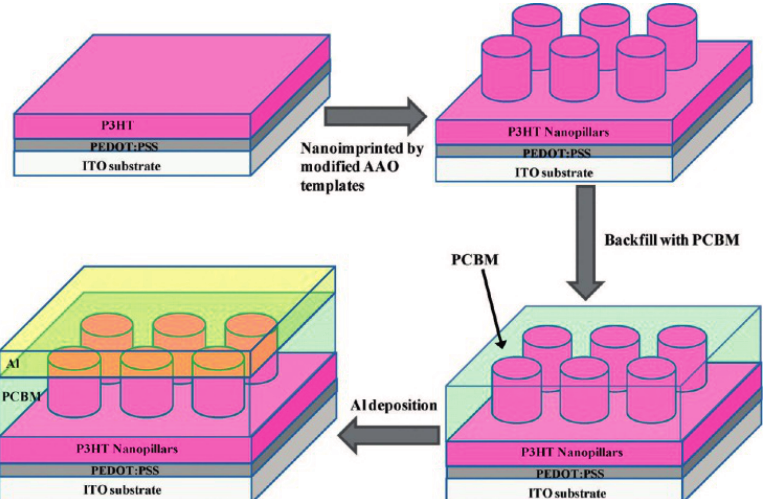
Figure 7. Procedure for the nanostructured organic photovoltaic device. Cited from [93]. Copyright 2012, America Chemical